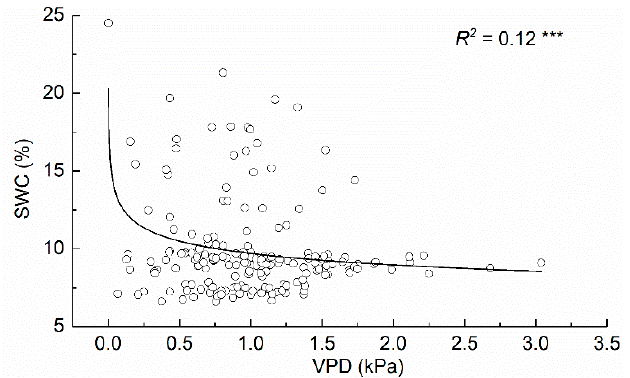
Figure 8. Correlation between the vapor pressure deficit (VPD) and soil water content (SWC) during growing season. *** p < 0.001.